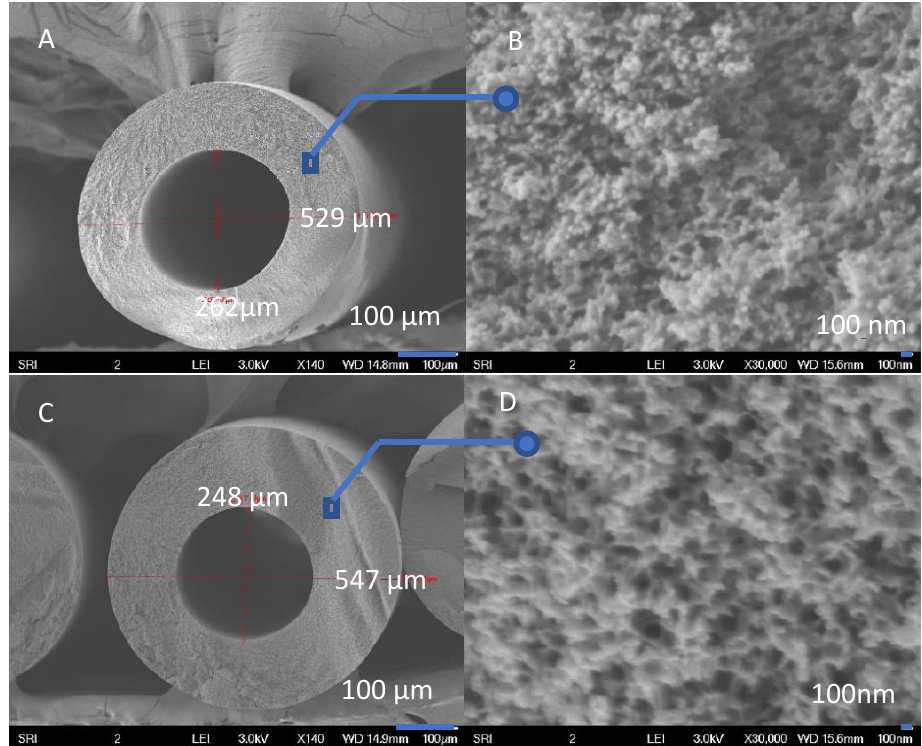
Figure 4 . The cross-section morphology of PBI HFs with air gap of ( A , B ) 0.5″ (1.3 cm) and ( C , D ) 4″. Figure 4. The cross-section morphology of PBI HFs with air gap of ( A , B ) 0.5” (1.3 cm) and ( C , D )